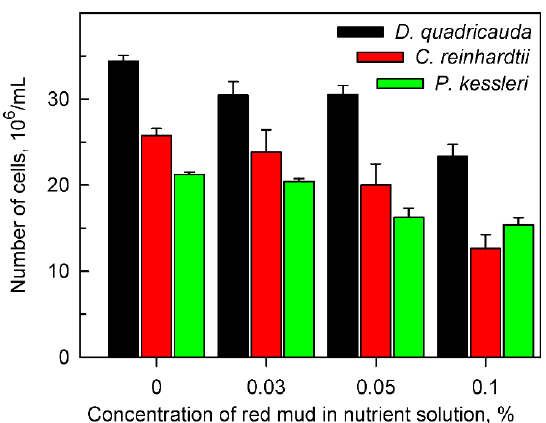
Figure 1. Cell number of Desmodesmus quadricauda , Chlamydomonas reinhardtii and Parachlorella kessleri after 48 h of growth in the absence (0%) or presence of different concentrations (0.03, 0.05, 0.1%) of red mud in nutrient medium suitable for the given species. All the cultures were diluted to the same initial number of cells (8 × 10 5 /mL) at the beginning of each experiment. Table 3. The growth rate ( µ ) of Desmodesmus quadricauda , Chlamydomonas reinhardtii and Parachlorella kessleri at different concentrations of red mud expressed as doubling of number of cells per day. Concentration of Red Mud Number of Cells, 10 6 /mL Growth Rate